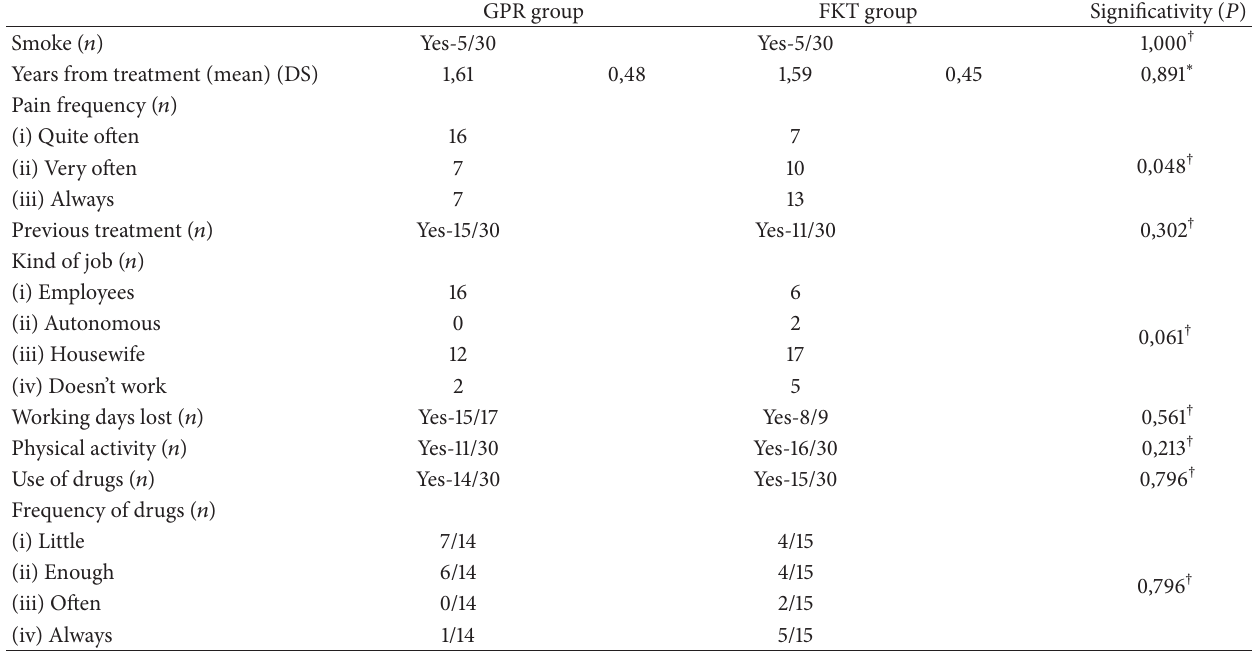
Table 4: Comparison of variables of low back pain questionnaire at